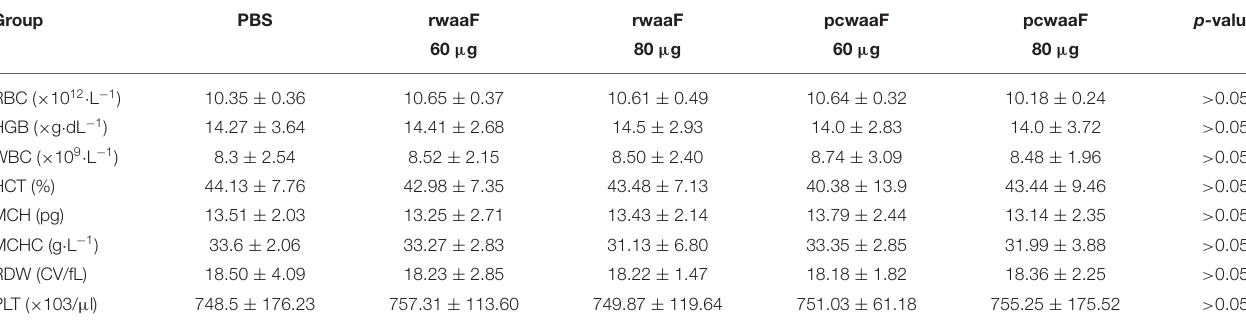
TABLE 4 | The results of hematologic about vaccinated BALB/c mice which were vaccinated rwaaF (60 and 80 µ g), pcwaaF (60 and 80 µ g), and PBS, respectively. Group PBS